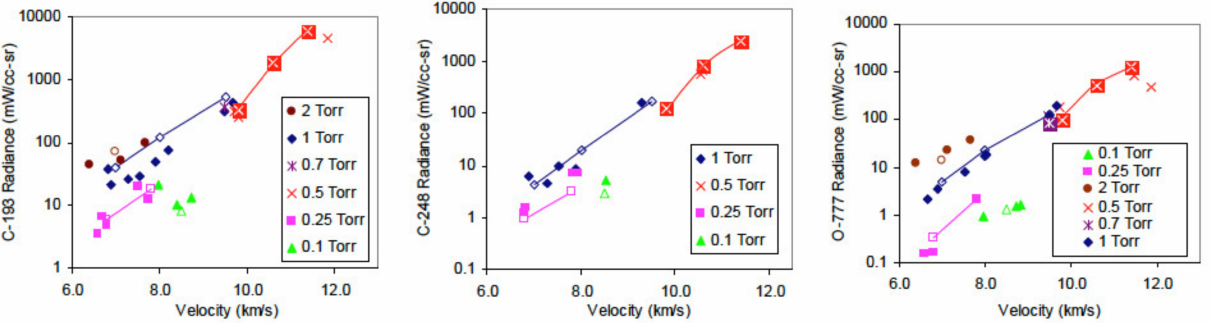
Figure 14. Integrated radiance from carbon lines (193 and 248 nm) and oxygen triplet (777 nm) (EAST experimental data as solid points; NEQAIR calculations as lines)